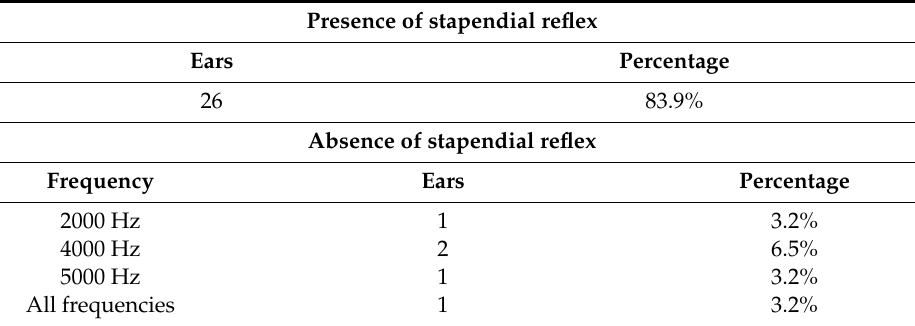
Table 11. Results of the stapendial